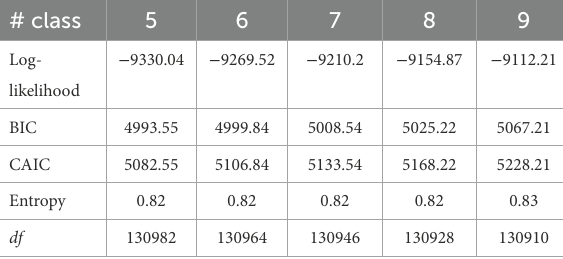
TABLE 1 Model fit indices and degree of freedom of the five